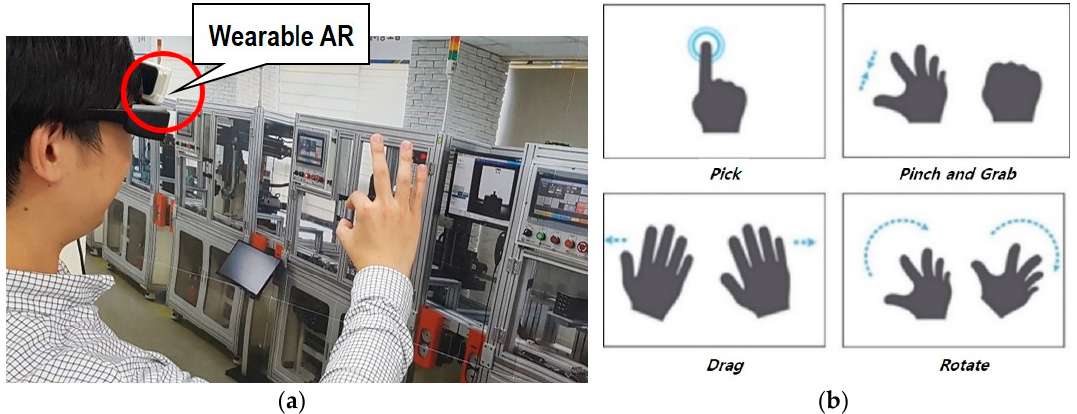
Figure 6. Hand gesture-based interaction ( a ) in wearable AR for monitoring a manufacturing service; ( b ) different types of hand gesture interactions.